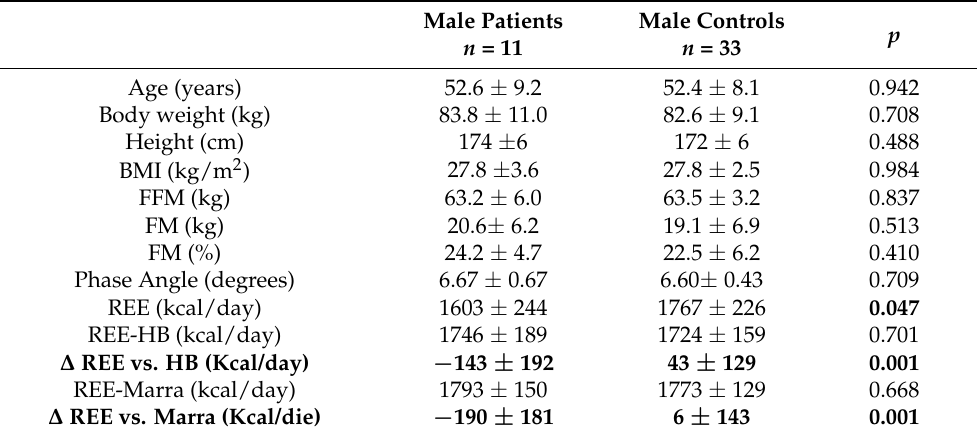
Table 3. Body composition and resting energy expenditure (measured and estimated) of male GD1 patients ( n = 11) compared to male healthy controls ( n = 33).